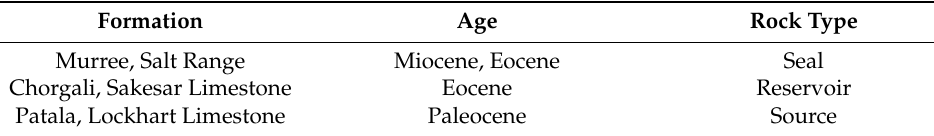
Figure 2. Stratigraphic column of eastern Potwar [22]. Table 1. Petroleum system of the study